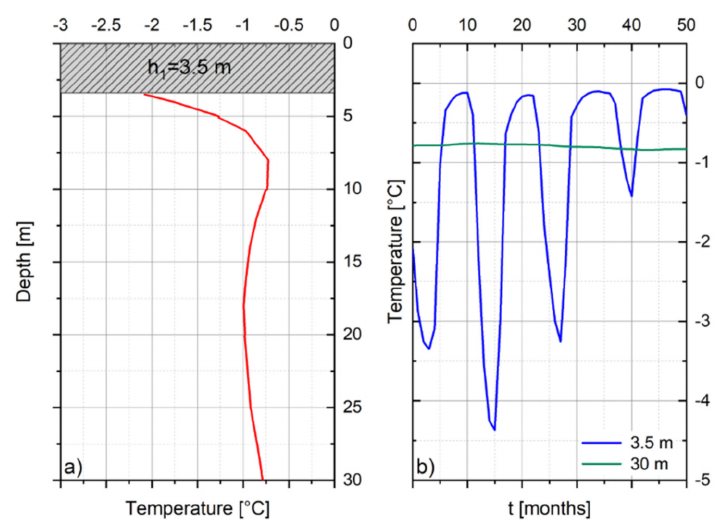
Figure 7. ( a ) Initial and ( b ) boundary conditions for the thermal problem.